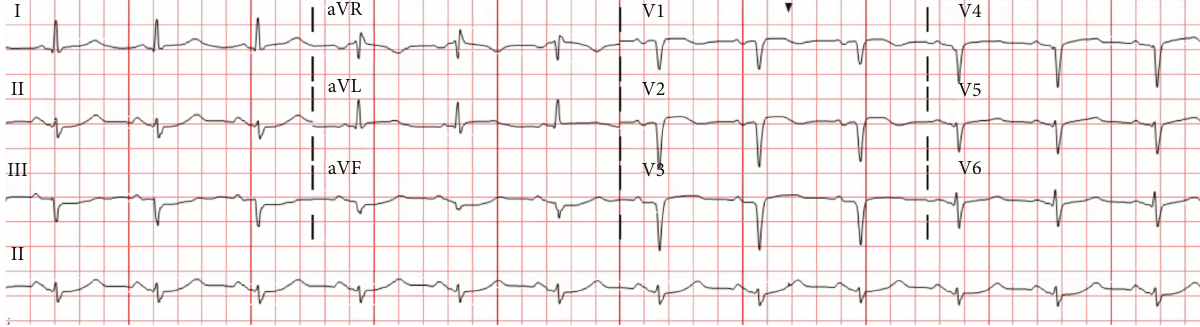
Figure 1: Electrocardiogram showing sinus rhythm at 74 beats/min, left axis deviation, Q waves in V1 to V3, 1mm ST segment elevation of V2-V3, and poor R wave progression.